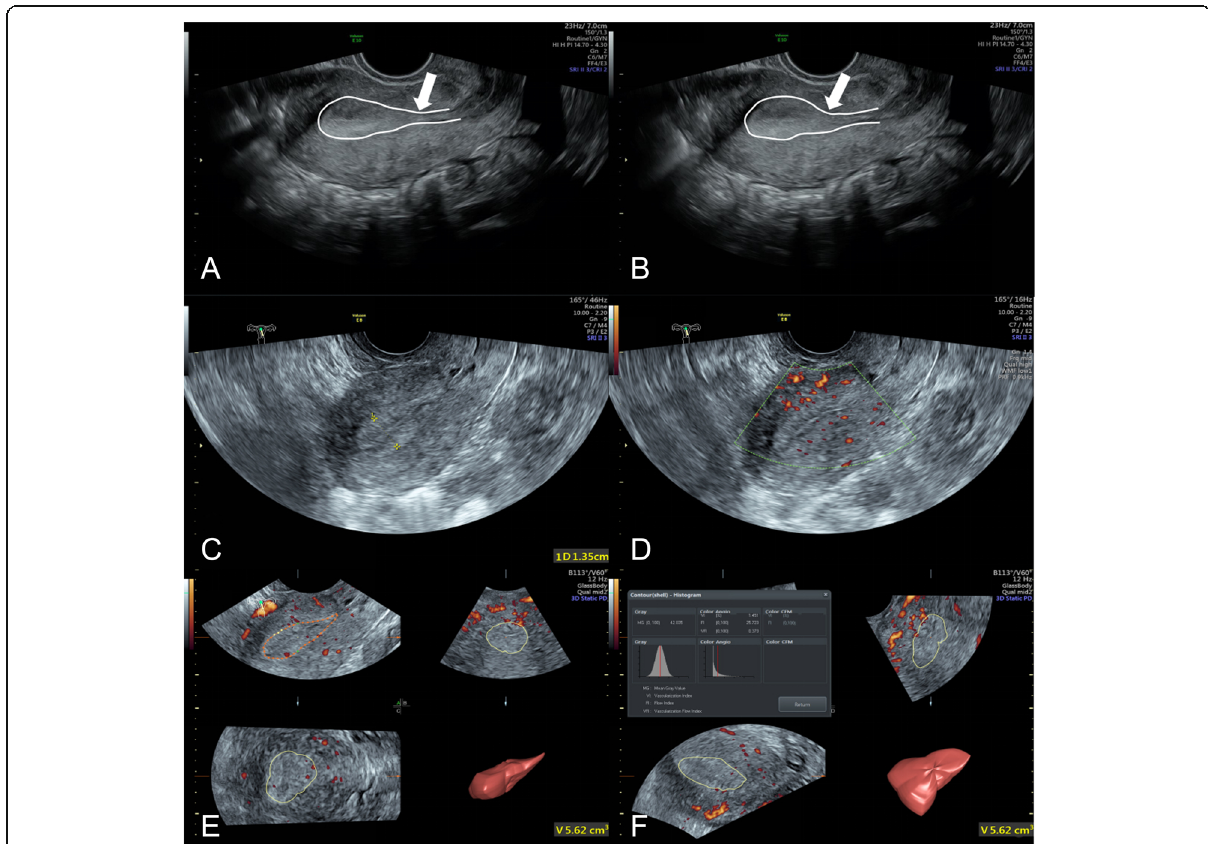
Fig. 4 Ultrasound images of a subject in the control group. a , b Two-dimensional gray-scale mode; two images of one peristalsis wave during observation. White curve, outline of endometrium. White arrow, incisura of peristalsis wave. Six positive endometrium peristalsis wave within 3 min (2/min); score, 3; c two-dimensional gray-scale mode; endometrial thickness, 13.5 mm; score, 3; endometrial type, type A; score, 3; d two- dimensional color Doppler mode; endometrial and subendocardial blood flow were observable; score, 3; e three-dimensional mode; endometrial volume, 5.62 cm 3 ; score, 3; f three-dimensional mode; VFI, 0.373; score,